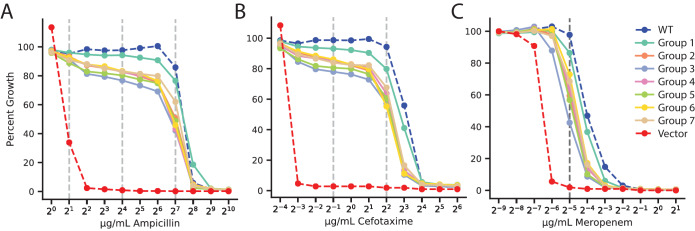
Antibiotic dose-response curves of VIM-2 libraries for all antibiotics.(A) Ampicillin. (B) Cefotaxime. (C) Meropenem. Y-axis indicates percent growth of E. coli transformed with plasmid library groups relative to no selection. The range of antibiotics tested is 1.0–1024 µg/mL for AMP, 0.0625–64 µg/mL for CTX, and 0.002–2.0 µg/mL for MEM. The dashed vertical lines indicate concentrations that were used in DMS.